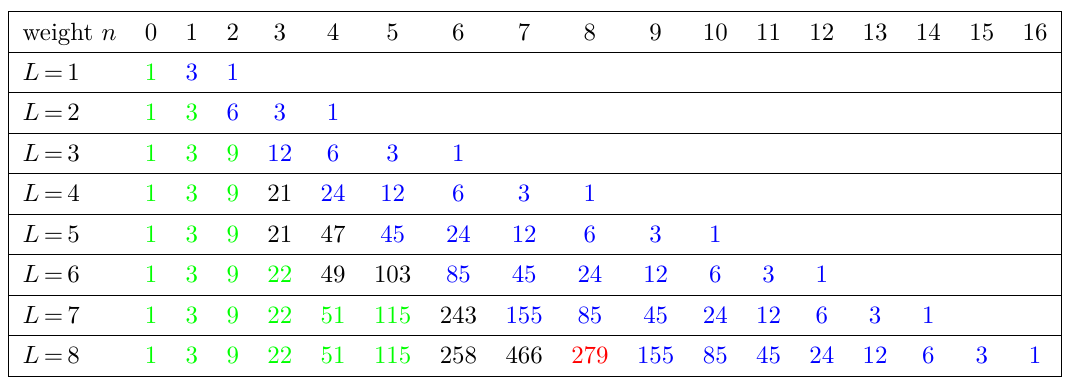
Table 3. The number of independent { n, 1 , 1 , . . . , 1 } coproducts of the form factor E ( L ) through L = 8 loops, at function level . The colors have the same meaning as in table